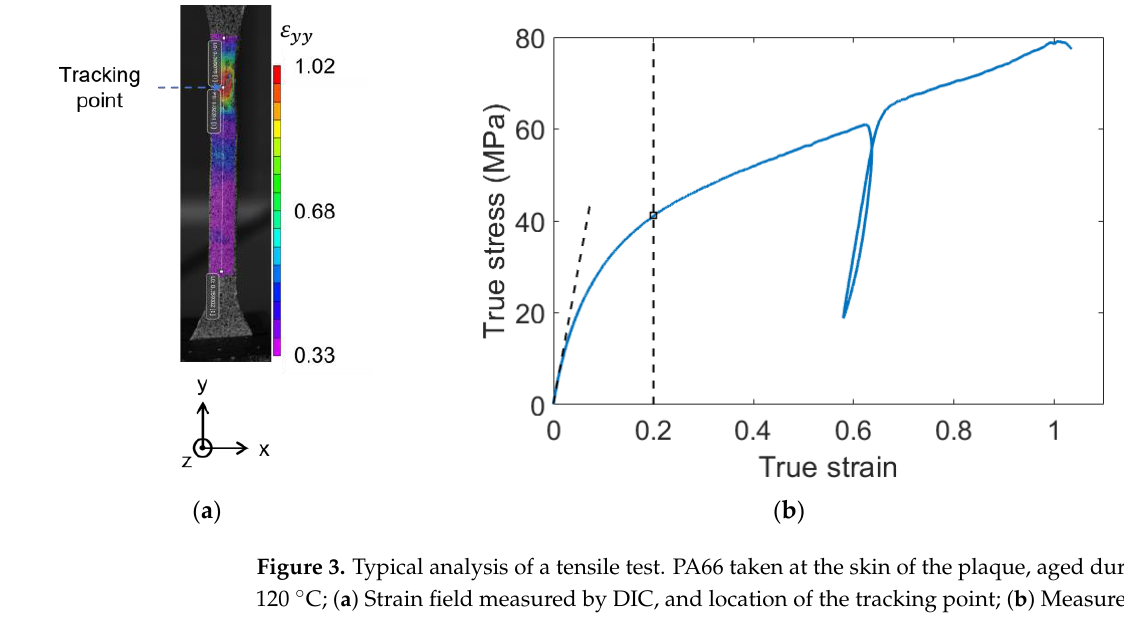
Figure 3. Typical analysis of a tensile test. PA66 taken at the skin of the plaque, aged during 168 h at 120 °C; ( a ) Strain field measured by DIC, and location of the tracking point; ( b ) Measurement of the elasticity modulus and the stress for a 0.2 strain. The strain was measured on the tracking point.